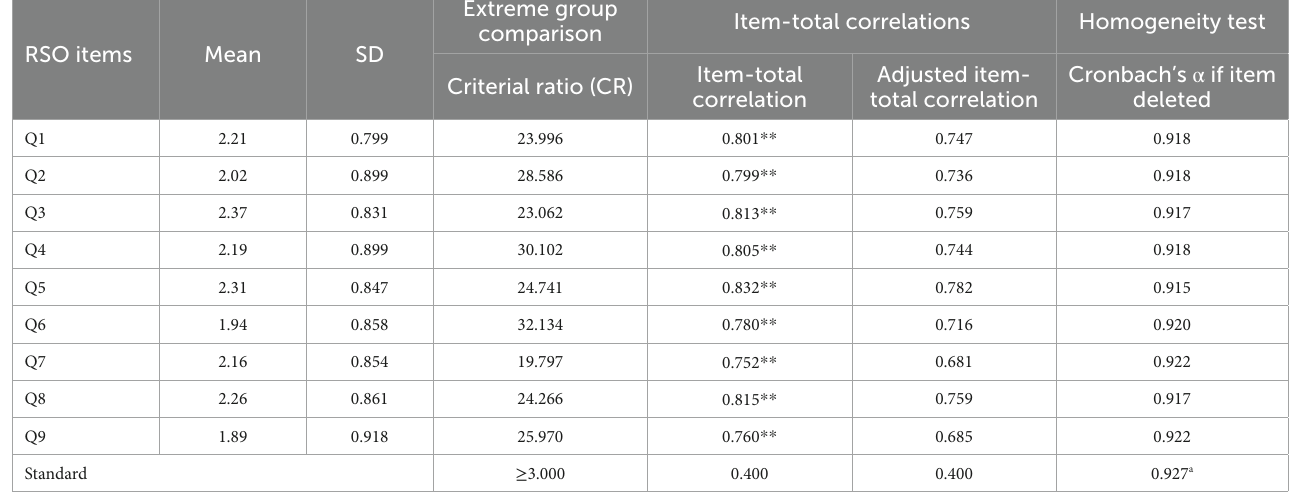
TABLE 2 Item analysis ( n =